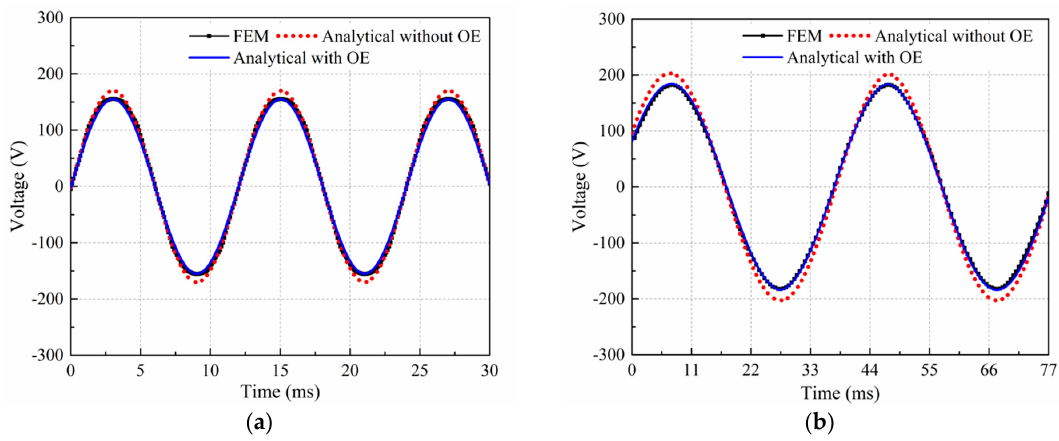
Figure 13. Back EMF of the DSLRPMM. ( a ) Rotary motion unit. ( b ) Linear motion unit.